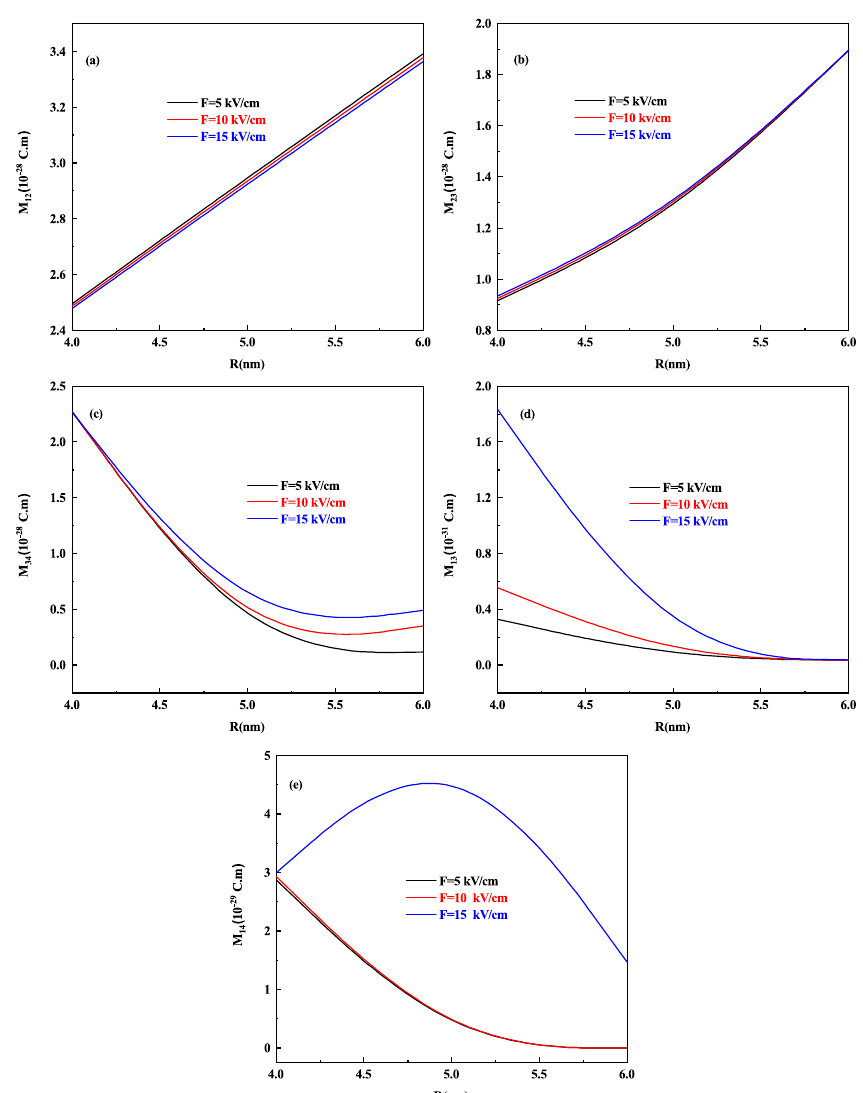
Figure 14. The DM elements ( a ) M 12 , ( b ) M 23 , ( c ) M 34 , ( d ) M 31 , and ( e ) M 41 as a function of prolate QD radius R with h =7 nm for different values of the perpendicular electric field F = 5, 10 and 15 kV/cm